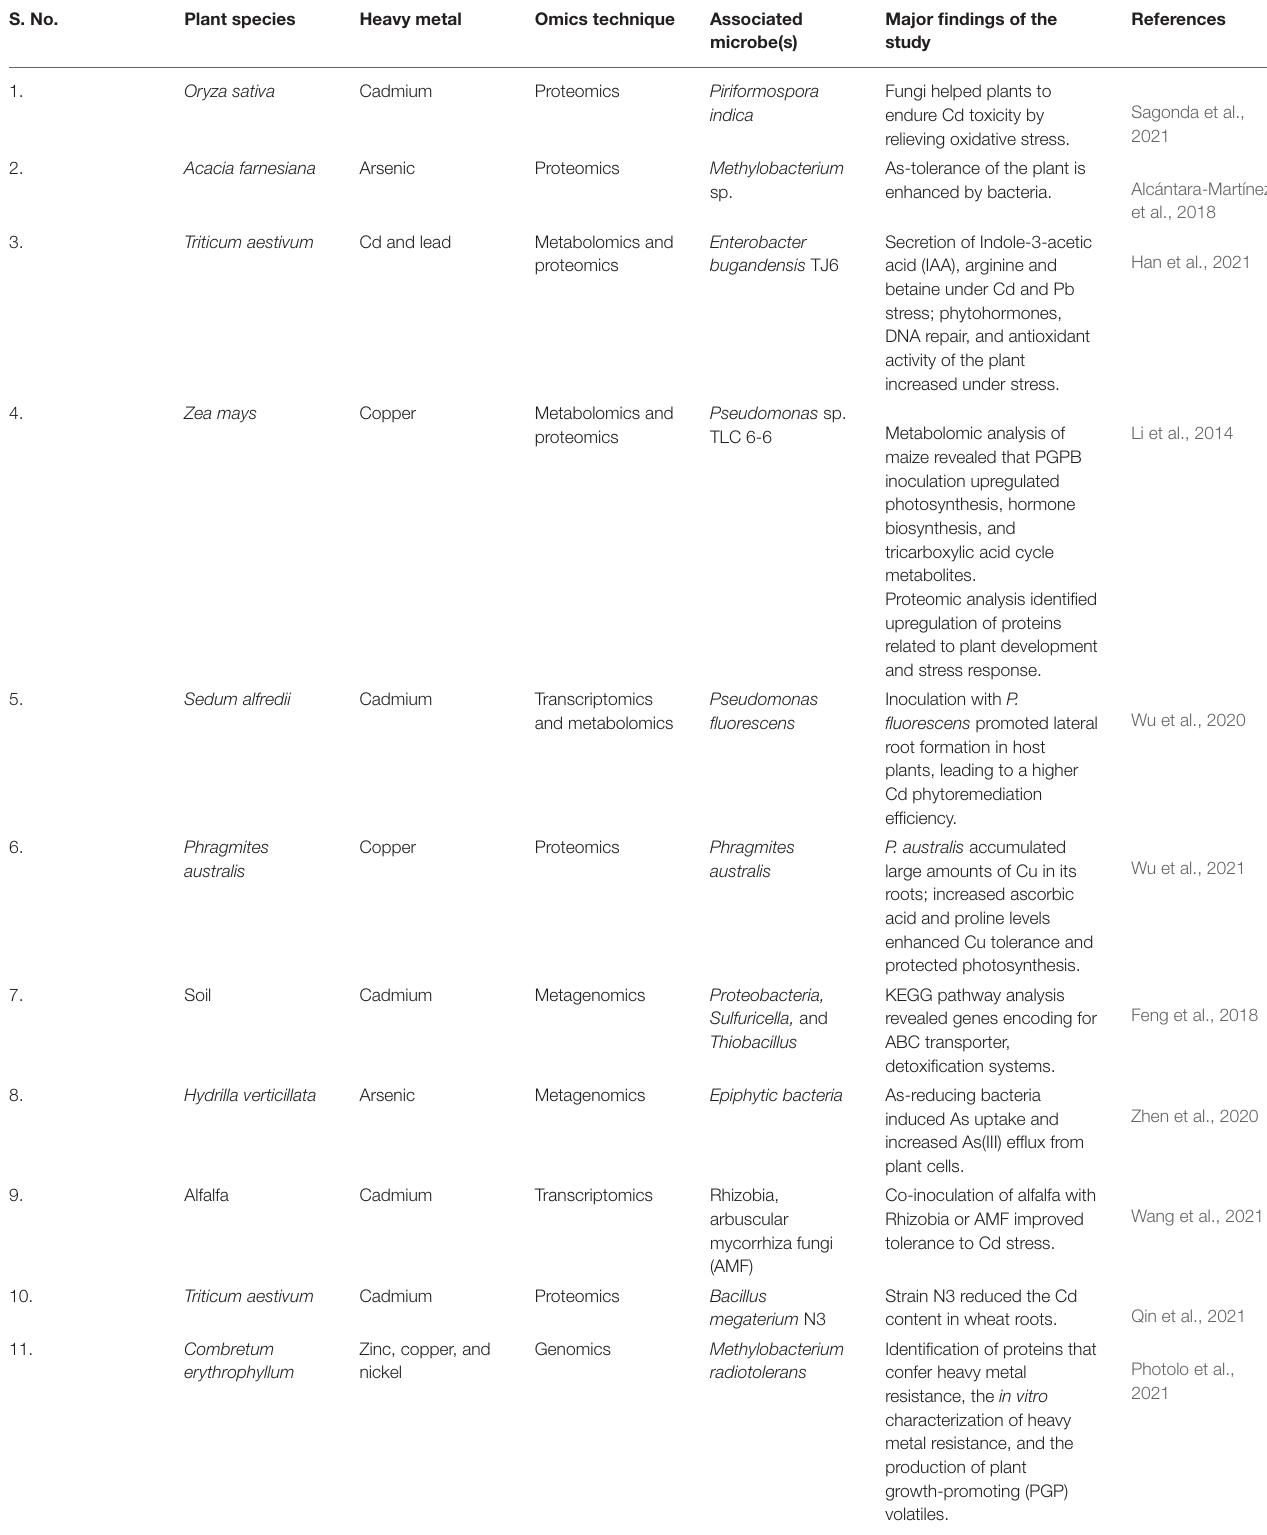
TABLE 1 | Some recent studies involving omics technologies for unraveling the role of microbiota in HM-tolerance. S.